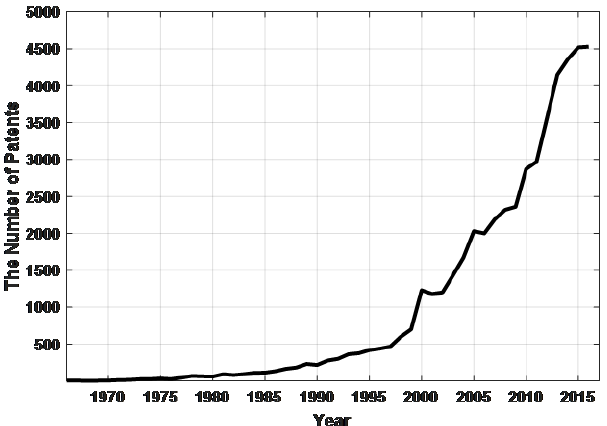
Fig. 1. The number of patents that involve noninvasive blood glucose keywords by